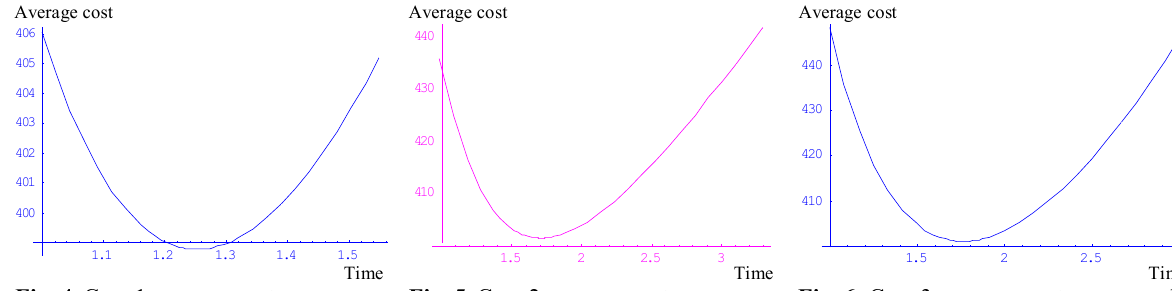
Fig. 4. Case 1: average cost versus Fig. 5. Case 2: average cost versus Fig. 6. Case 3: average cost versus